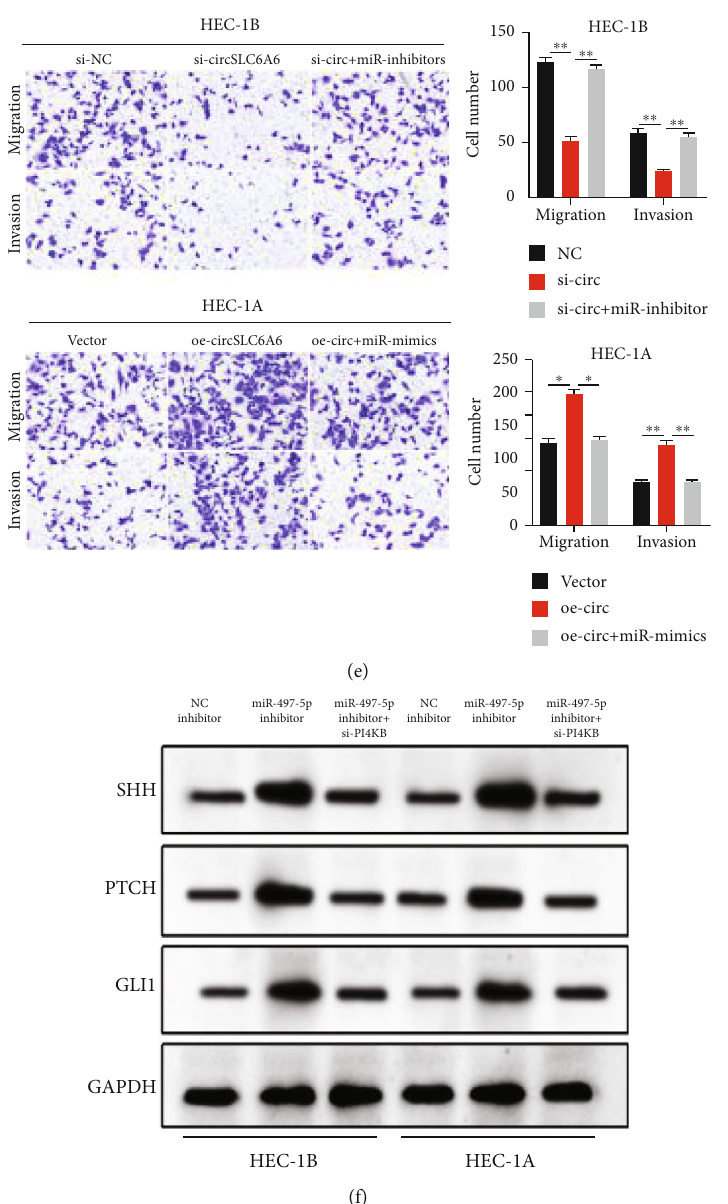
Figure 5: circSLC6A6 promotes EC cell proliferation, migration, and invasion via miR-497-5p/PIK4B/hedgehog. (a) The expressions of PI4KB and hedgehog in HEC-1B and HEC-1A cells were detected by western blot. (b, c) The proliferation abilities of HEC-1B and HEC- 1A cells by the colony formation assay and EdU assay. (d) Wound healing assay was conducted to detect the migration of treated EC cells. (e) The migration and invasion abilities of HEC-1B and HEC-1A cells were detected using the transwell assay. (f) The expressions of GLI1, PTCH, and SHH proteins in HEC-1B and HEC-1A cells ( ∗∗ p < 0 : 01